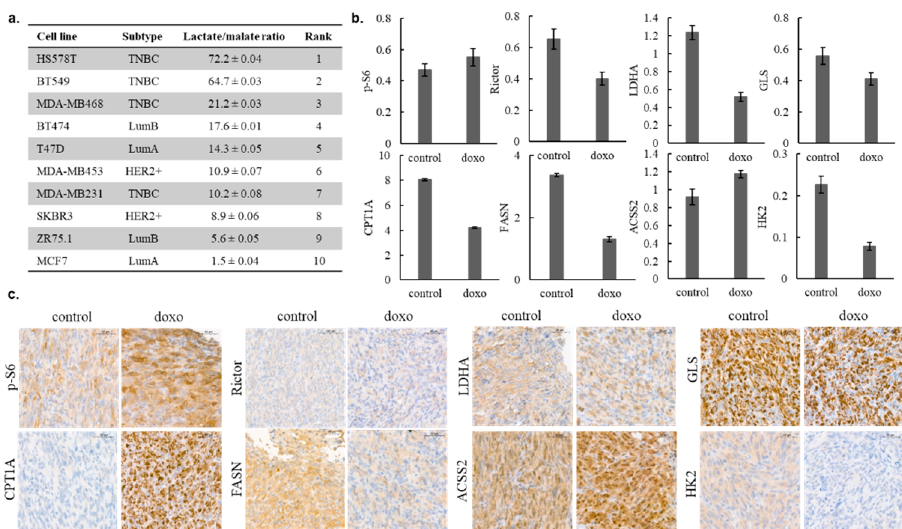
Figure 4. Intracellular lactate–malate ratio as a characteristic of human breast cancer cells; in vitro and in vivo metabolic adaptation of MD-MB231 cells after doxorubicin treatment. Intracellular metabolite concentrations were measured by LC-MS, the lactate–malate ratio was calculated from the ng/10 6 concentrations, and the cell lines were ranked in accordance with their glycolytic versus oxidative phosphorylation (OXPHOS) shift ( a ); mTOR and metabolic activity-related enzyme levels were assessed by WES Simple, and the protein levels normalised to β -actin were measured in control and in in vitro 72 h doxorubicin-treated (50 ng/mL, doxo) cell lysates ( b ); the same protein-level alterations were studied by immunohistochemistry (IHC) analysis in in vivo doxorubicin (21 days, 2 mg/kg/week)-treated MD-MB231 tumour xenografts ( c ). Scale bars are given in the figures.